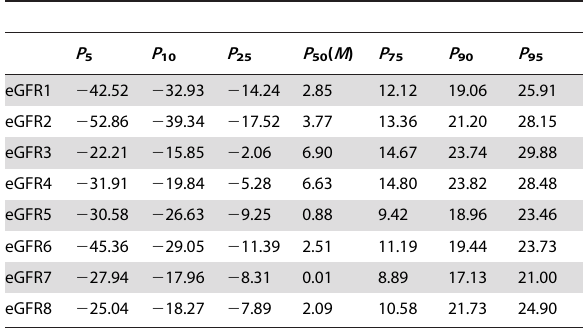
Table 4. Percentiles ( P ) of difference between eGFR and rGFR (mL/min N 1.73 m 2